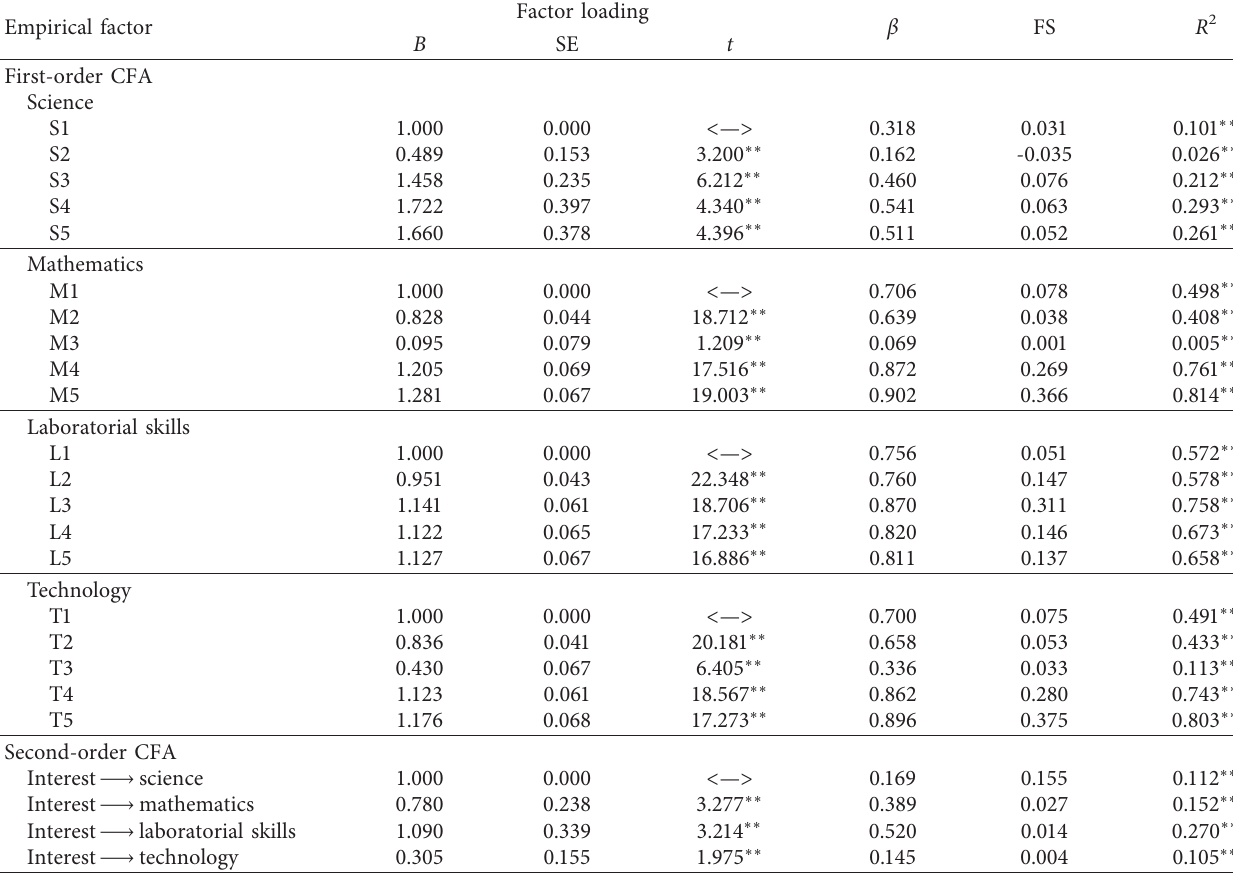
Table 3: Result of the confirmatory factor analysis (CFA) of the assessing interest in the stem content scale. Empirical